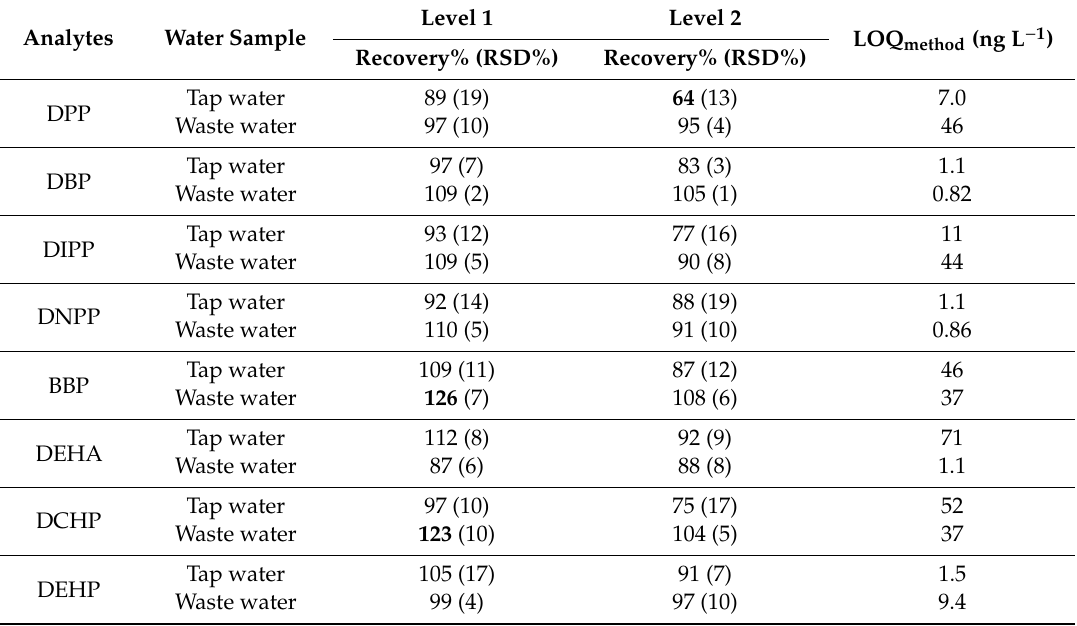
Table 2. Relative recovery and RSD (between parenthesis) values of the target analytes in water samples ( n = 3 at each spiking